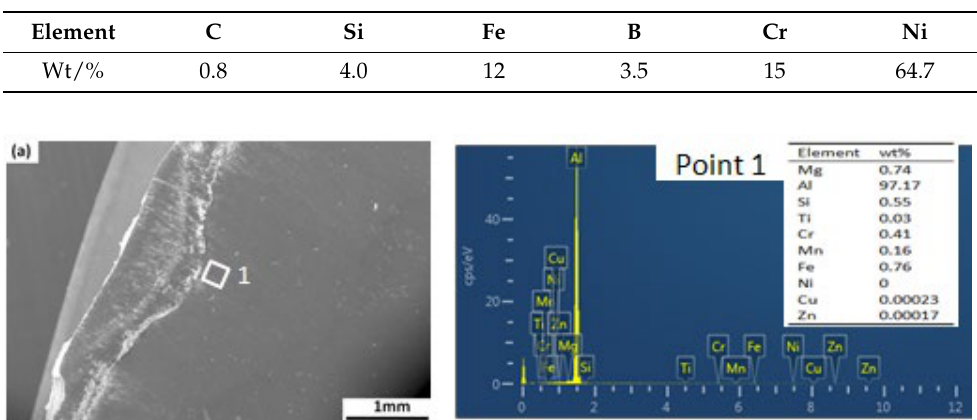
Table 6. Chemical composition of 6061 aluminum alloy. Element Figure 9. Cross-sectional morphology and EDS analysis for different coating thicknesses: ( a ) 0.5 mm; ( b ) 1 mm; ( c ) 1.5 mm. Through the cross-sectional morphology and EDS analysis mentioned above, it was found that the metallurgical bonding effect of the molten cladding layer with a preset coating thickness of 1 mm was better, which again verified the agreement with the sim- ulation results. 5. Conclusions (1) The simulation results of the temperature field of the cladding process show that the peak temperature of the same node on the surface of the molten layer rose with the increase in the thickness of the preset coating; the melt depth and width of the melt pool increased with the addition of the preset coating, and the melt depth of the substrate de- creased with the increase in the thickness of the preset coating. (2) The simulation results of the thermally coupled stress fields show different re- sidual stress distributions on different paths for different preset coating thicknesses. The maximum residual stresses in the molten layer along the central axis of the scan appeared near the end edge and increased with the increase in the coating thickness. The maximum residual stresses along the depth direction appeared at the junction of the coating and the substrate and increased with increasing coating thickness in the 0–6 mm interval. It could be concluded that the thickness of the preset coating is one of the most important factors causing the variation in the residual stress. (3) The macroscopic surface morphology of the clad layer showed that the surface of the 0.5-mm-thickness coating had more defects such as pores and pits after melting; the surface of the 1-mm-thickness coating was relatively flat after melting, and the surface of